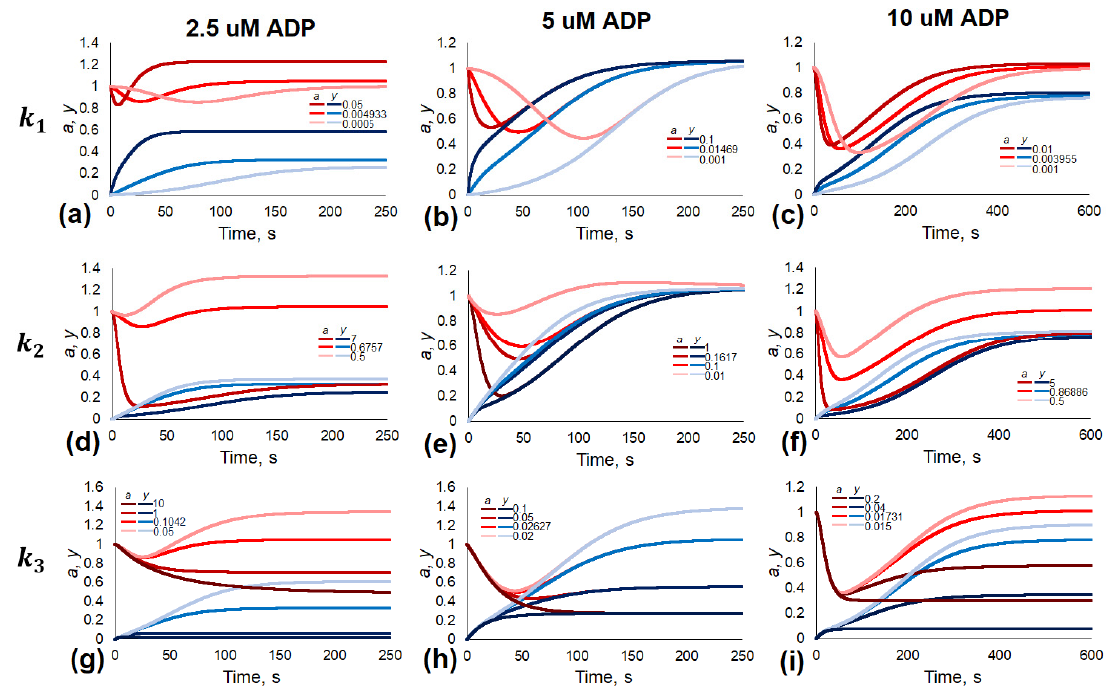
Figure 6. The effects of variations in parameter values on the model responses. Time courses for a ( t ) and y ( t ) for parameter sets given in Table 1 for the corresponding ADP concentrations with one parameter being varied for each plot. For panels ( a – c ) k 1 was varied; for ( d – f ) k 2 was varied; for ( g – i ) k 3 was